Question: Judging by this figure, is the value going up or going down?
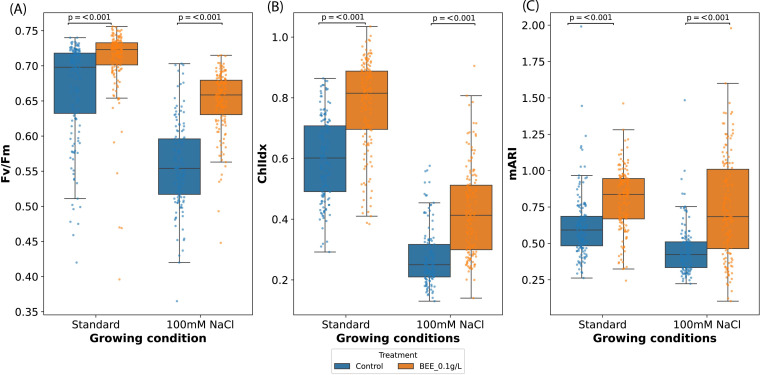
Answer: increasing